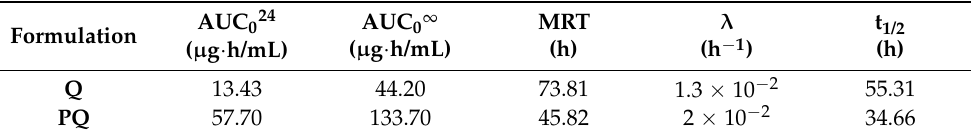
Table 1. Pharmacokinetic parameters after intraperitoneal administration of P-quercetin and natural quercetin ( n = 5 per group). Q: quercetin (50 mg/kg, i.p.); PQ: P-quercetin (100 mg/kg, i.p.). AUC 024 : area under the partial curve; AUC 0 ∞ : area under the total curve; MRT: mean residence time; t 1/2 : elimination half-life; λ : terminal phase slope.